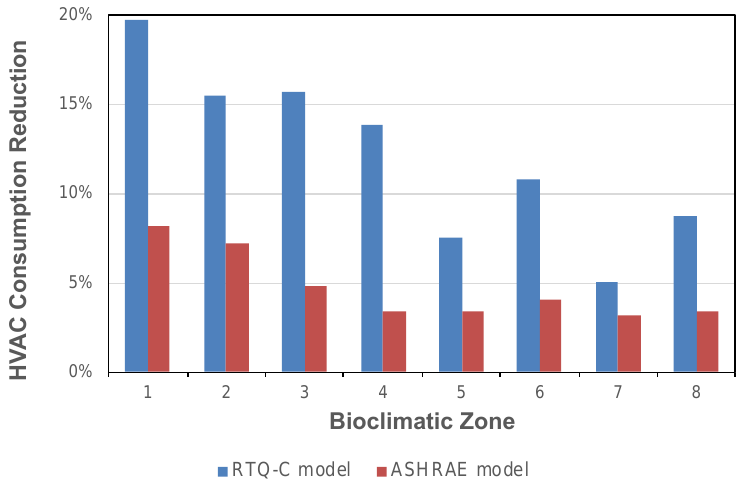
Figure 11. HVAC Reduction for T ch /T ctw integrated optimization control. Finally, when analyzing the reduction in consumption with the three integrated models (Figure 12), the results vary in relation to the RTQ-C model between −5 .03% and −1 9.68%, and in relation to the ASHRAE model between −3 .22% and −8 .21%. The highest reductions are for zones 1 to 3, due to the interaction with the T as control.